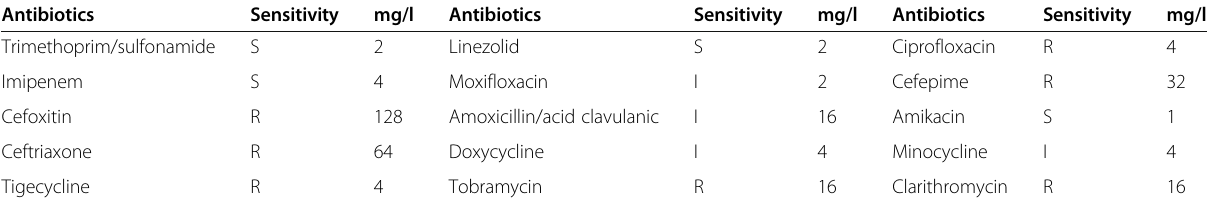
Table 1 Antibiotic qualitative and quantitative (mg/l) sensitivity of Nocardia farcinica ; (S - Antibiotic sensitive, R - Antibiotic-resistant, I - Antibiotic intermediate